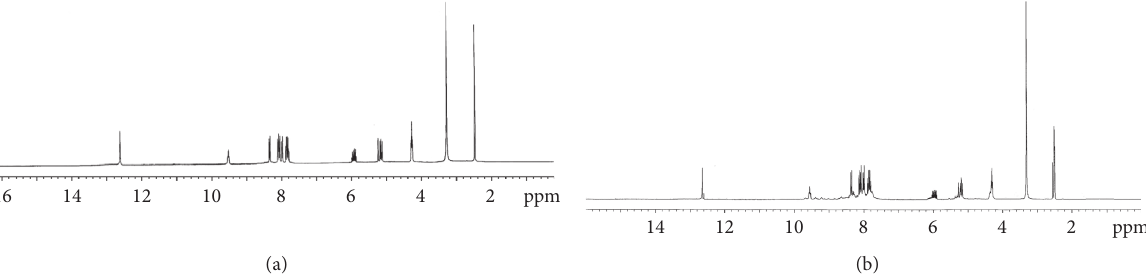
Figure 5: 1 H NMR spectra of HAAT (a) and Zn(II) complex (b) in DMSO-d